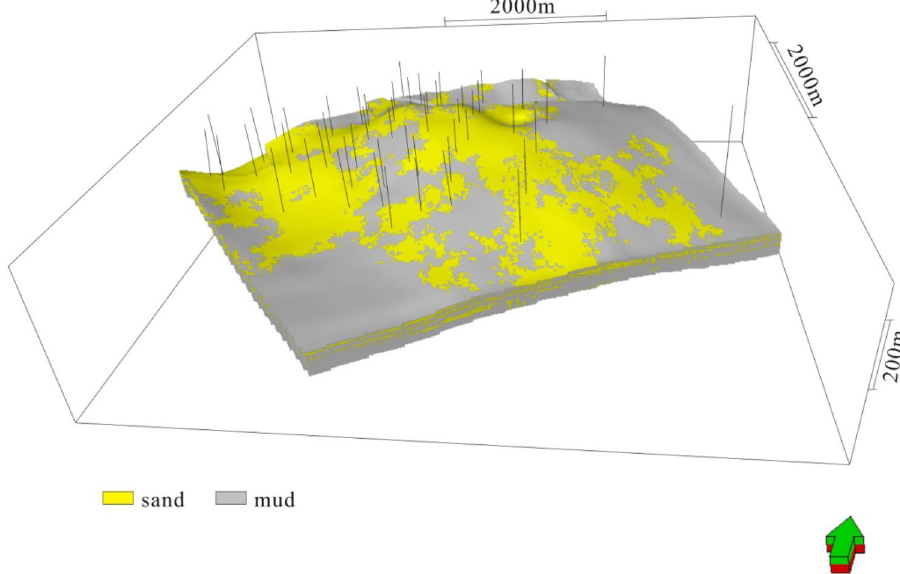
Fig. 4 Parameters of variograms of Maxi Oilfield Fig. 5 Three-dimensional facies model of Maxi